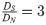
Conditions for a deterministic Turing instability.(a) Dispersion relations for βR = 6.5 and βS = 3.65 (blue diamonds) and βR = 6.5 and βS = 3.7 (red stars). The data used in this figure are included in S1 Data. (b) Region in the plane (βS,βR) where the maximum of λRe(Λ(α)) is positive and the equilibrium point is stable, for a ratio of diffusion coefficients DSDN=3. Parameters are set as kR = 0.2, αR = 0.2, K = 2, kS = 0.1, αS = 0.1, μS = 0.1, kN = 0.7, αN = 0.3, μN = 3, DS = 3, DN = 1, and Ω = 40.